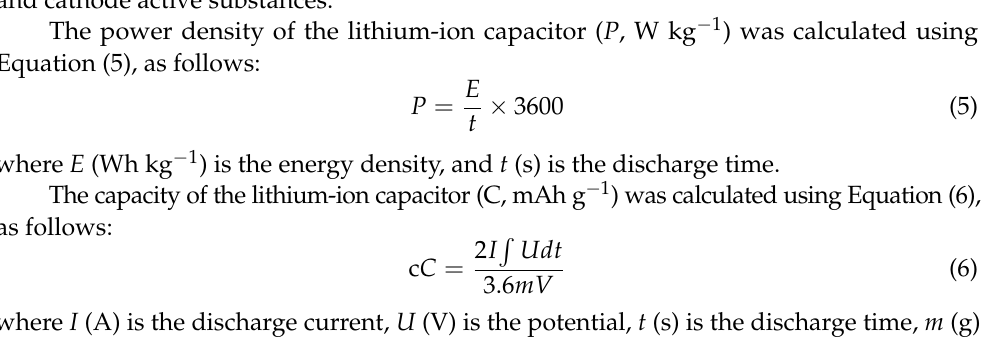
ton structure and rough surface. Figure S6: Raman spectrum of PC and N − PC. Figure S7: SEM images of the Nb 2 O 5 prepared at different reactive temperatures. Figure S8: Physical character- izations of PC and N − PC. Figure S9: CV curves of (a) PC and (b) N − PC at different scan rates. Figure S10: Electrochemical properties of N − PC cathode. Figure S11: Electrochemical properties Table S2: Analysis of the fitted C1s peaks from XPS. Table S3: Analysis of the fitted O1s peaks from XPS. Table S4: Porosity parameters of PC and N −